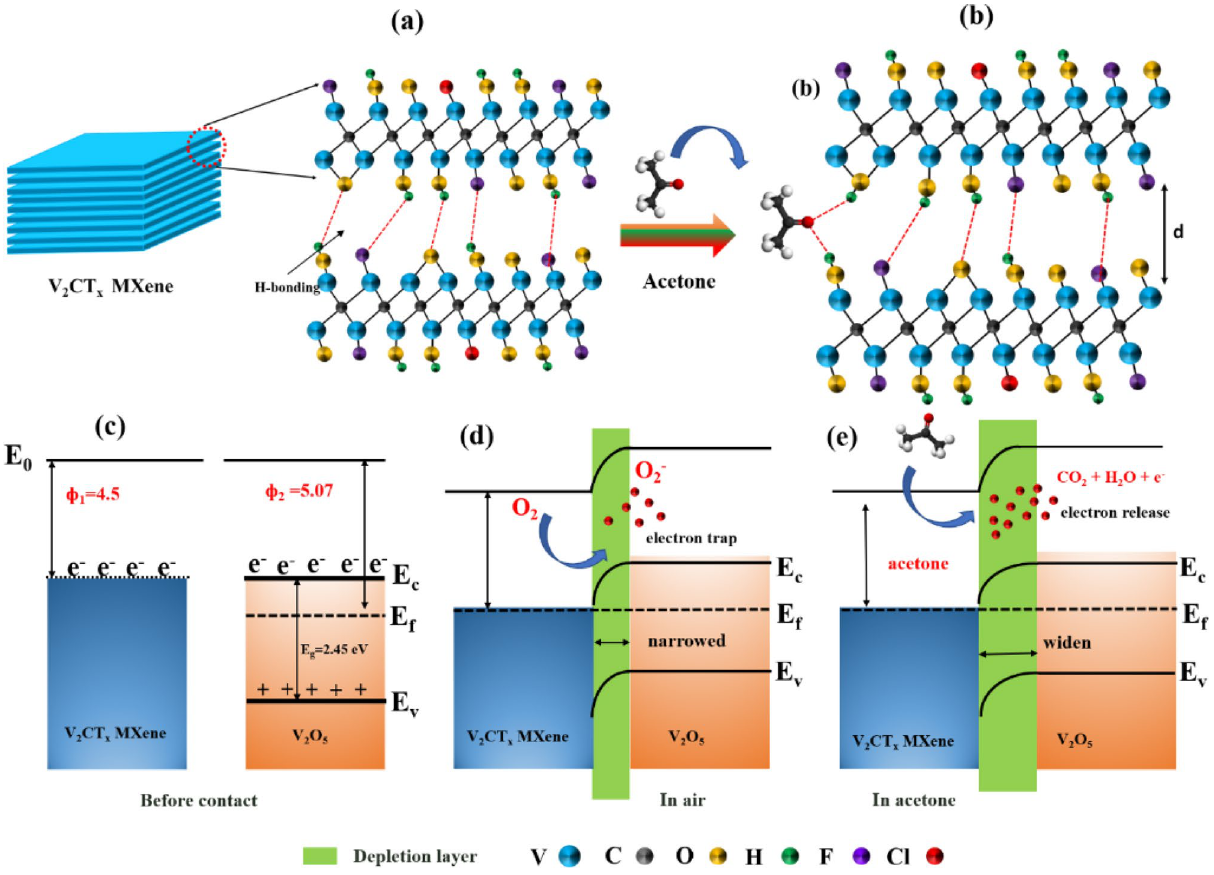
Figure 8. ( a , b ) Sensing mechanism of pristine V 2 CT x MXene toward acetone at RT; energy-band diagram of the V 2 CT x − V 2 O 5 heterostructure before contact ( c ), in the air ( d ), and in acetone ( e